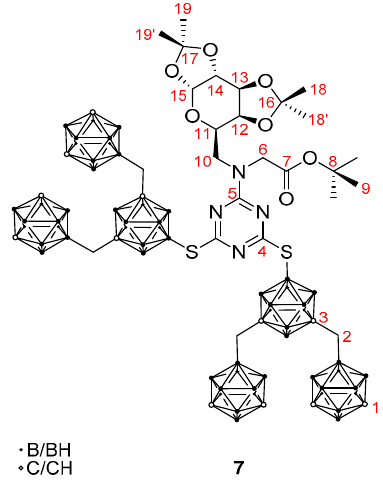
Figure 7. Numbering scheme of compound 7 .